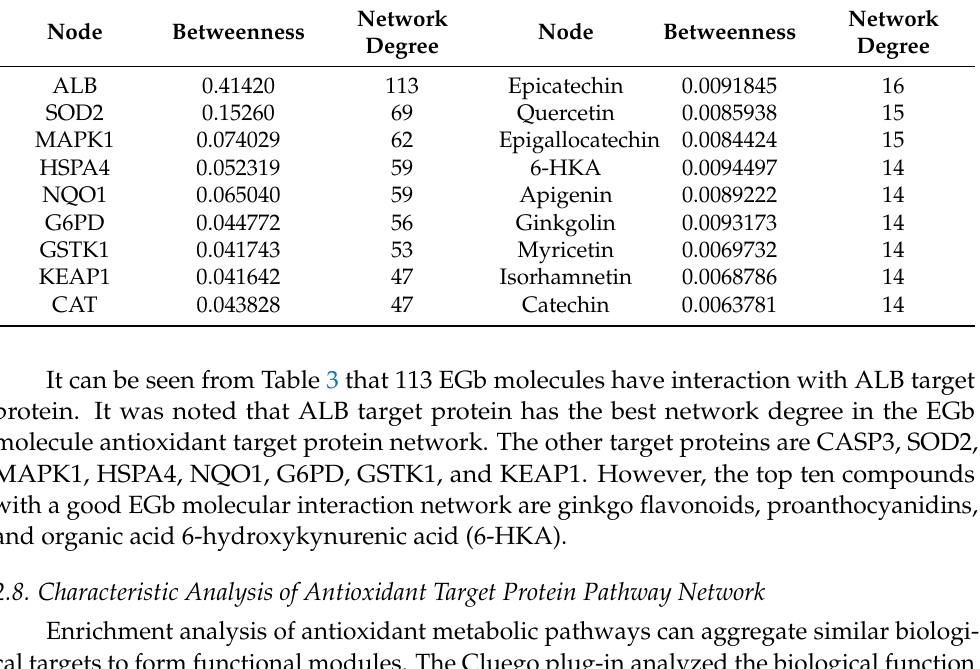
Network Node Betweenness Degree